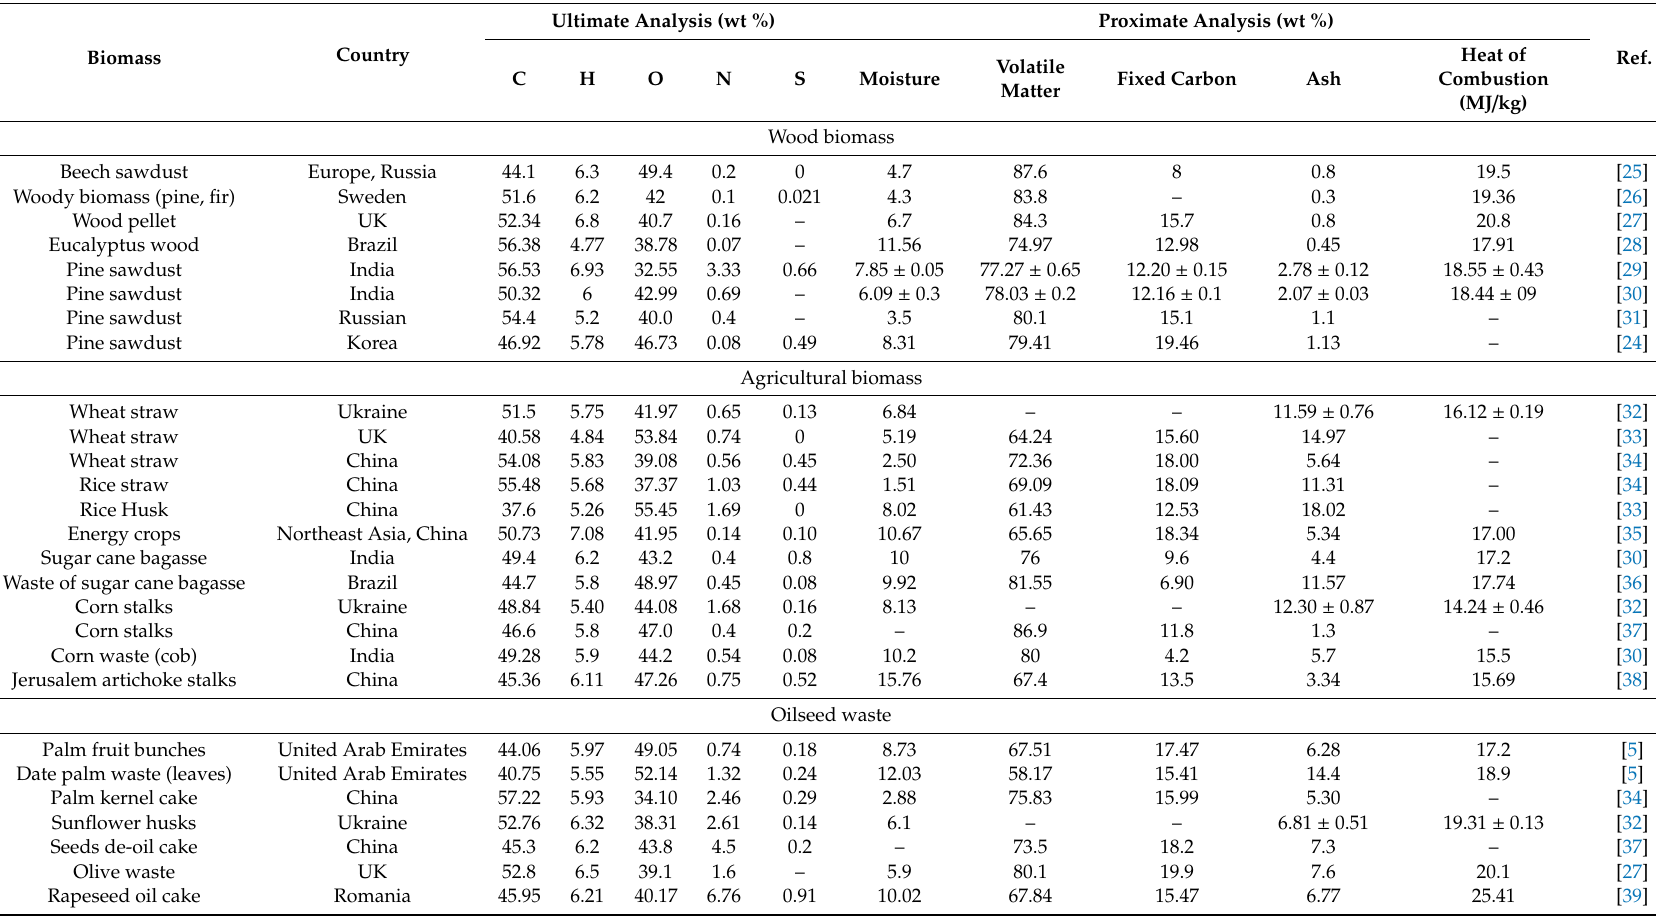
Table 1. Kinds and characteristics of biomass, produced in abundance and used in fuel technologies in the world.